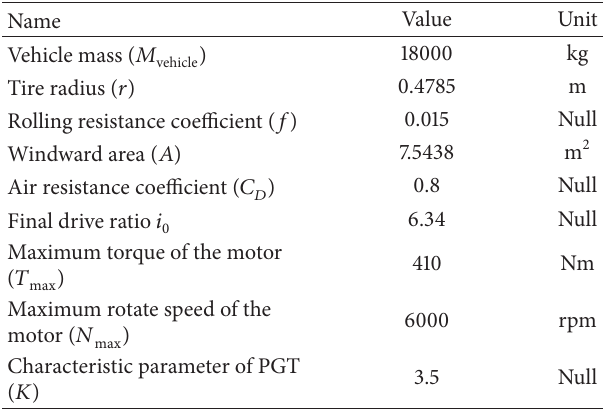
Figure 1: The dual-motors coupling-propulsion electric bus model- ing configuration. Table 1: Basic parameters of the vehicle and